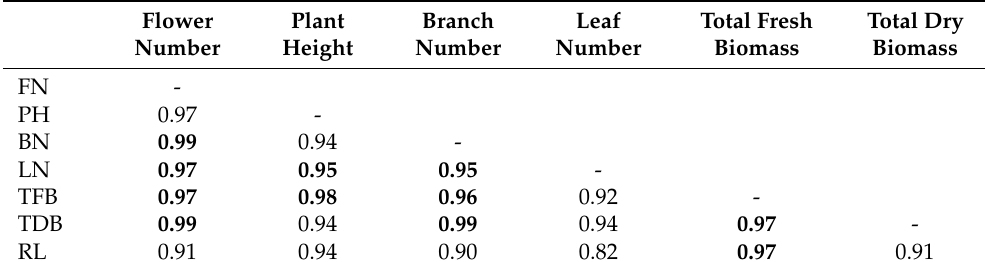
Table 6. Correlation coefficients between tested periwinkle variables (significant correlations are marked in bold, p < 0.05, N = 80).